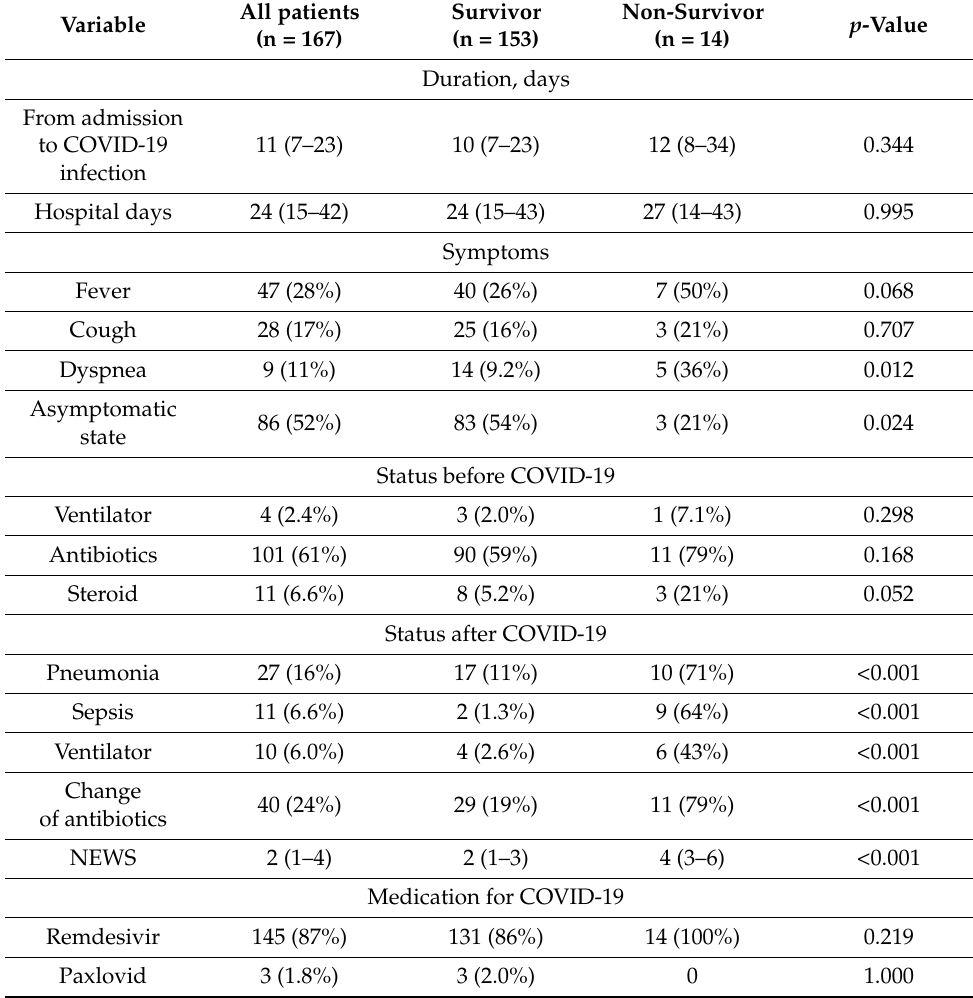
Table 2. Hospital course and outcomes of patients with nosocomial